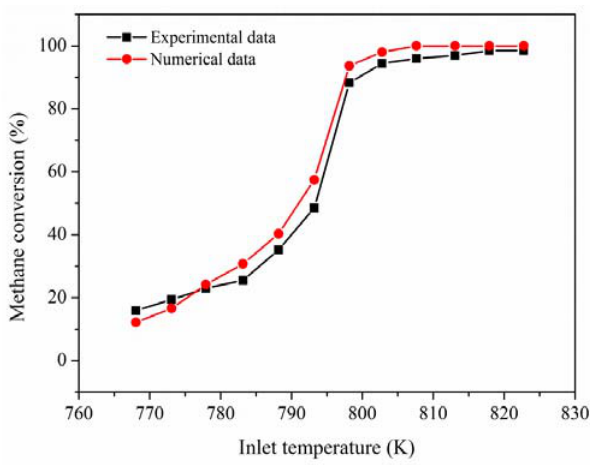
Figure 11. Verification of the model: methane conversion.